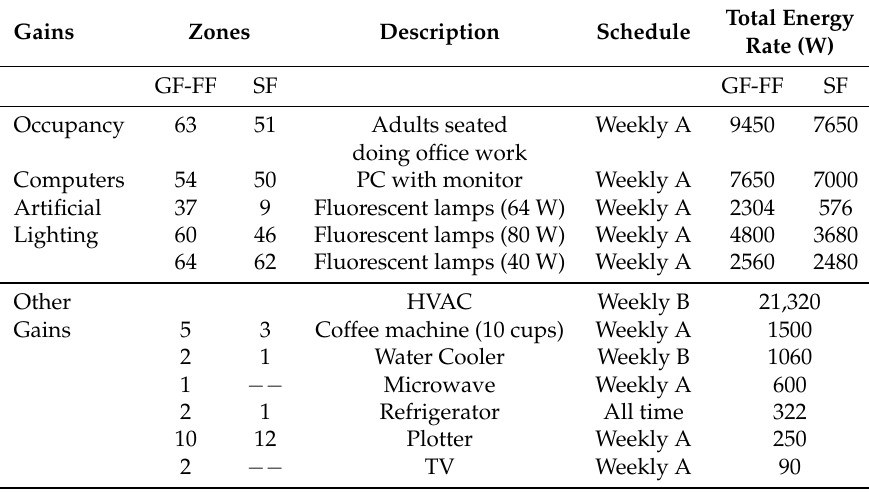
Table 4. Input data of internal gains in the different zones on Mexico case.